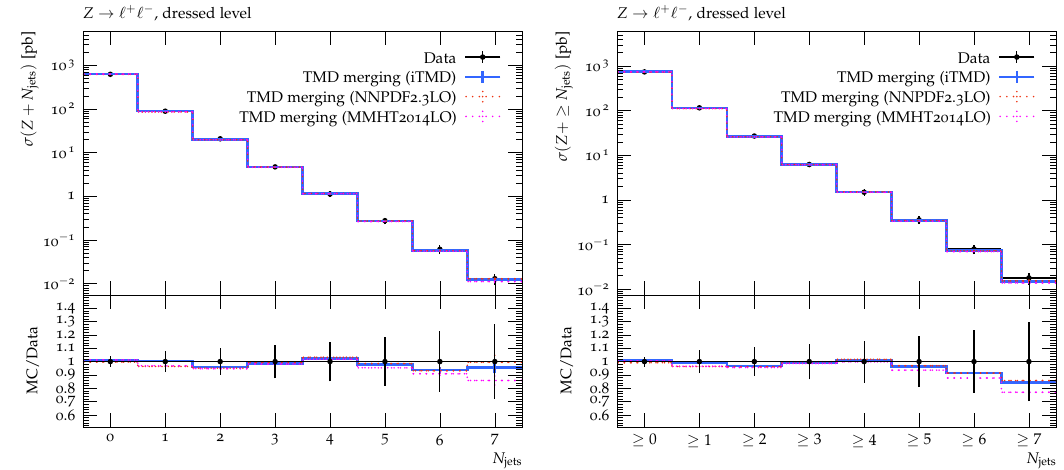
Figure 33 . Exclusive (left) and inclusive (right) jet multiplicity distributions in Z +jets: PDF sensitivity.